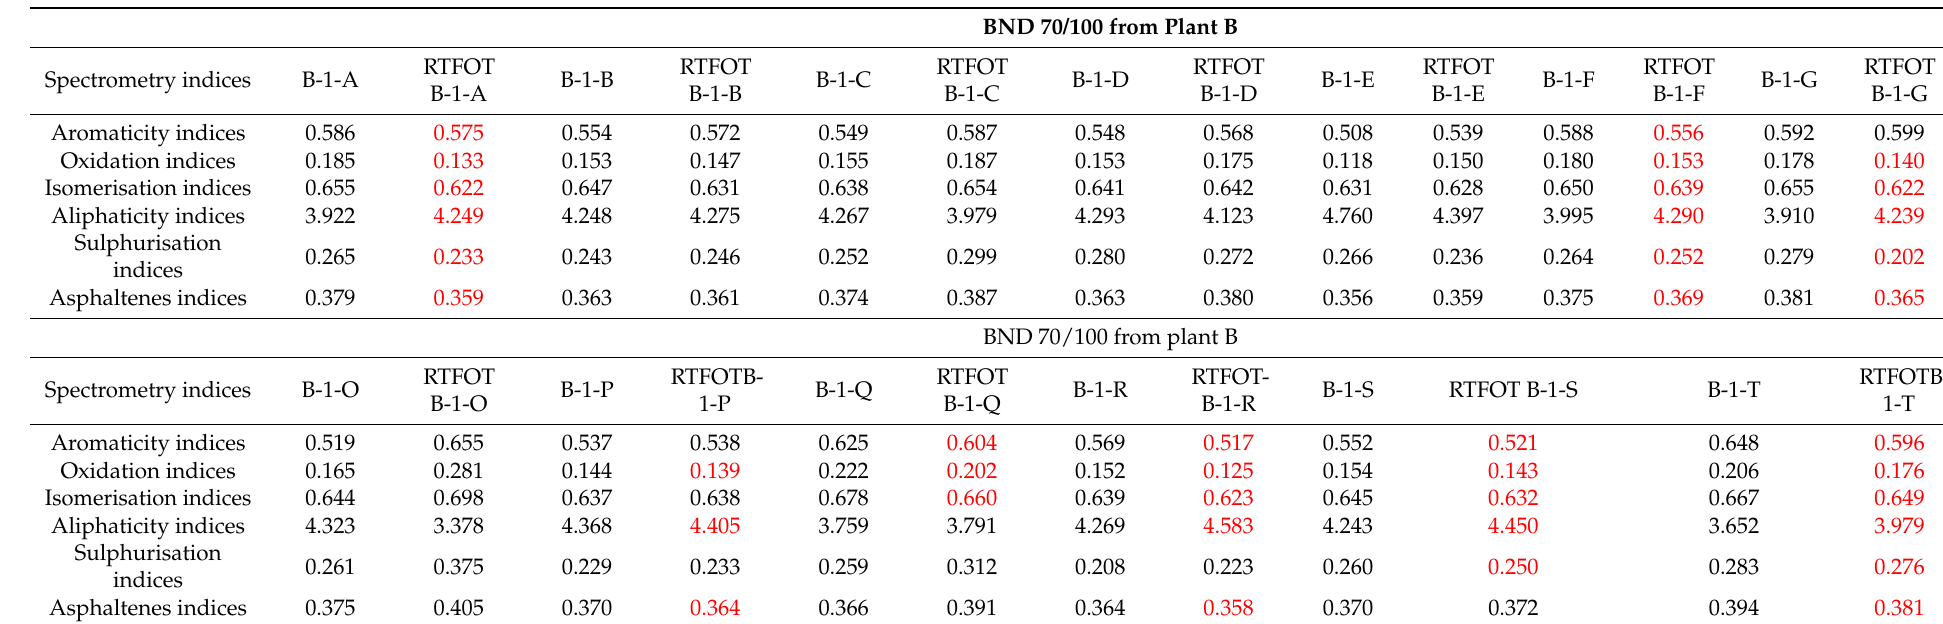
Table 10. Calculation of spectrometry indices of BND 70/100 from plant B before and after RTFOT.